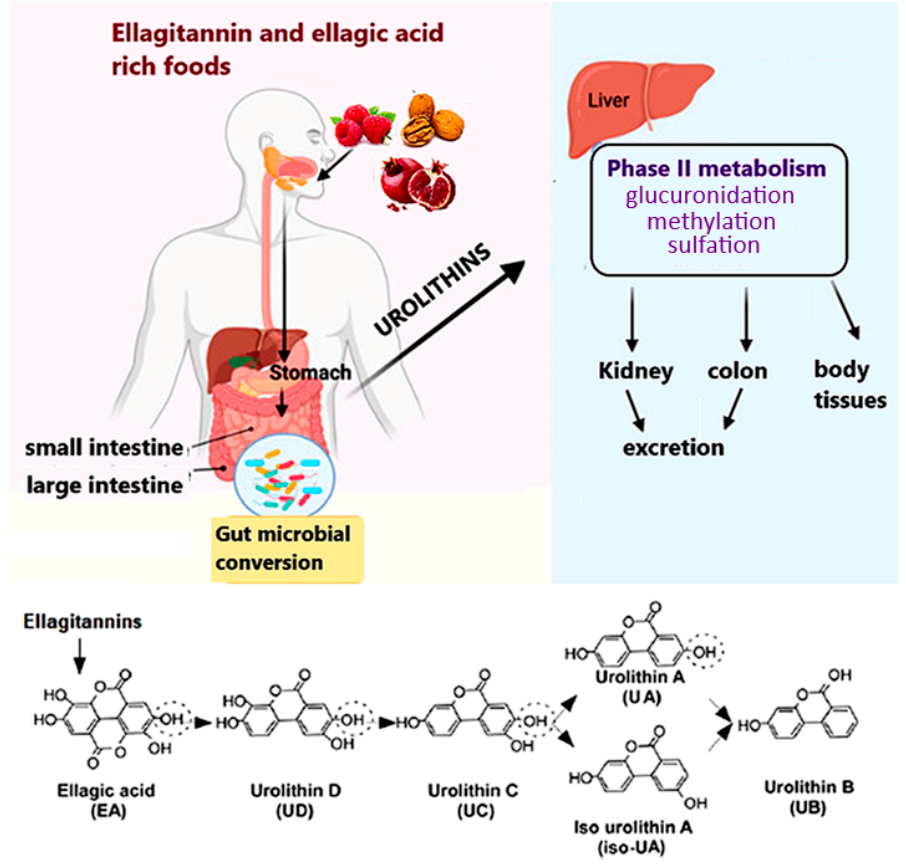
Figure 1. Ellagitannins and their hydrolysable derivative, ellagic acid, are natural polyphenols abun- dant in some fruits, nuts, and seeds. Ellagitannin is metabolized by gut microbiota into distinct types of urolithins that are further converted by large intestine enterocytes and the liver into conjugates. Both conjugated and unconjugated urolithins enter the blood circulation system and reach the body tissues. Besides accumulation in certain organs, urolithins are excreted in urine and feces [9]. Figure was adapted from